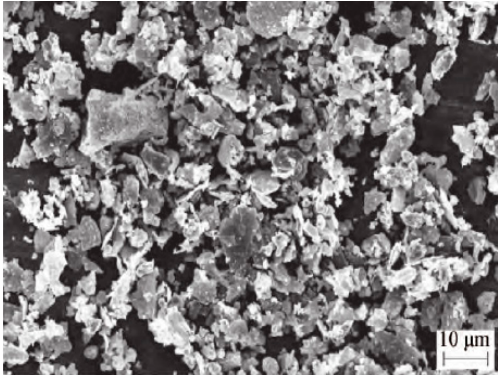
Figure 12. SEM image of a high-performance filler.